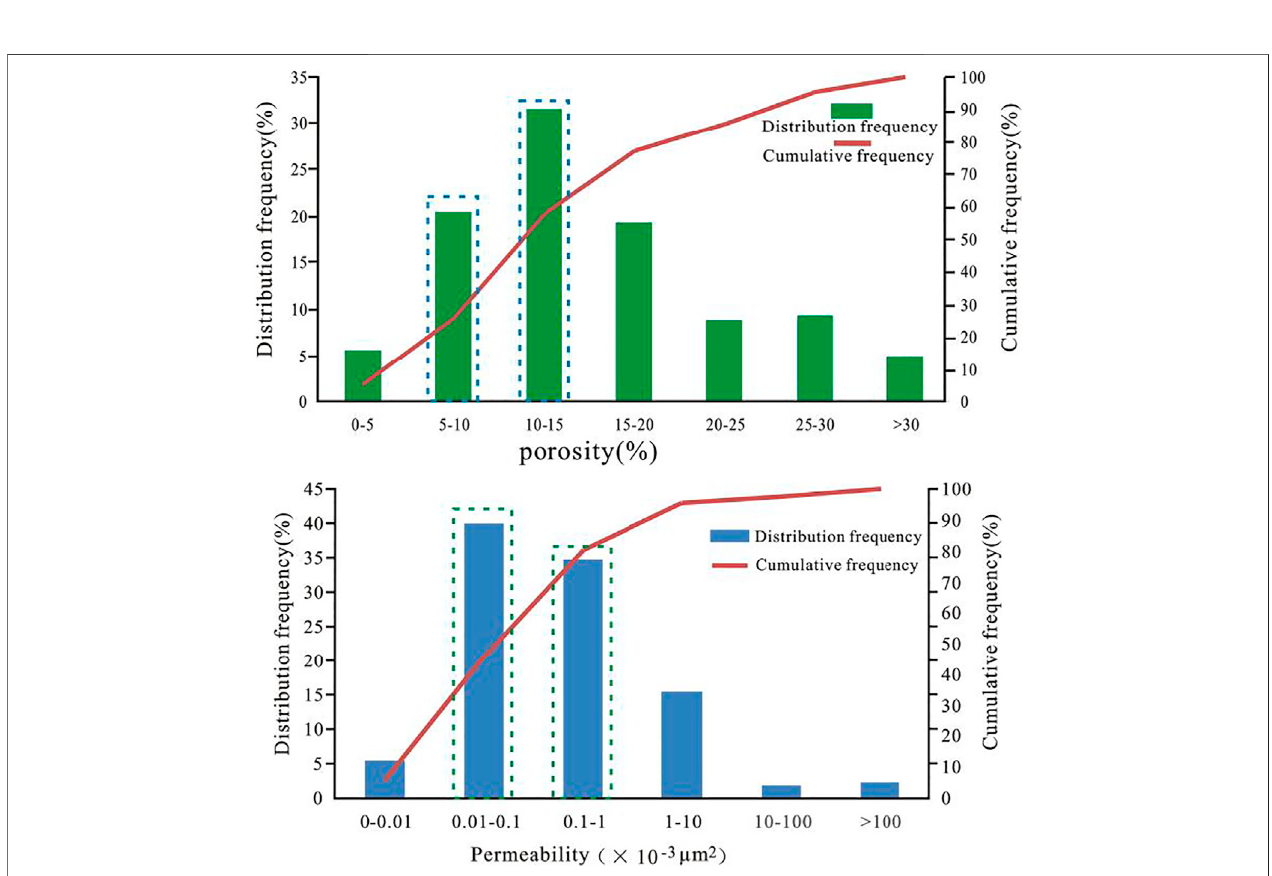
FIGURE 5 | Distribution frequency of porosity and permeability of the Mesozoic volcanic rocks in the D oil fi eld of the Laizhouwan sag.